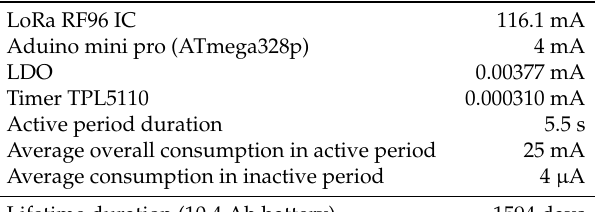
Table 3. Consumption of every element of the beacon prototype along with lifetime duration estimation.